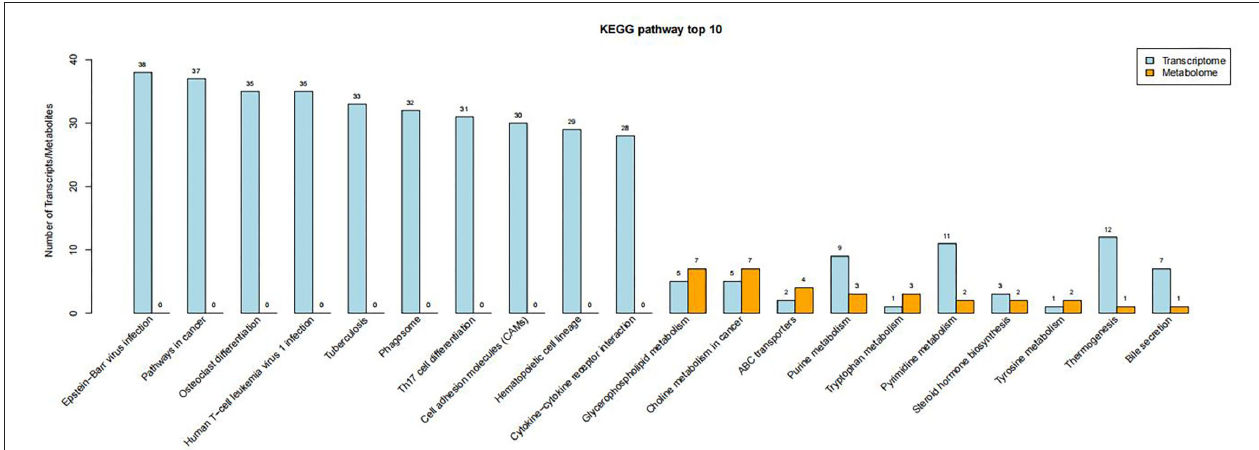
FIGURE 6 | Top 10 KEGG pathways containing the most DEGs and altered metabolites.